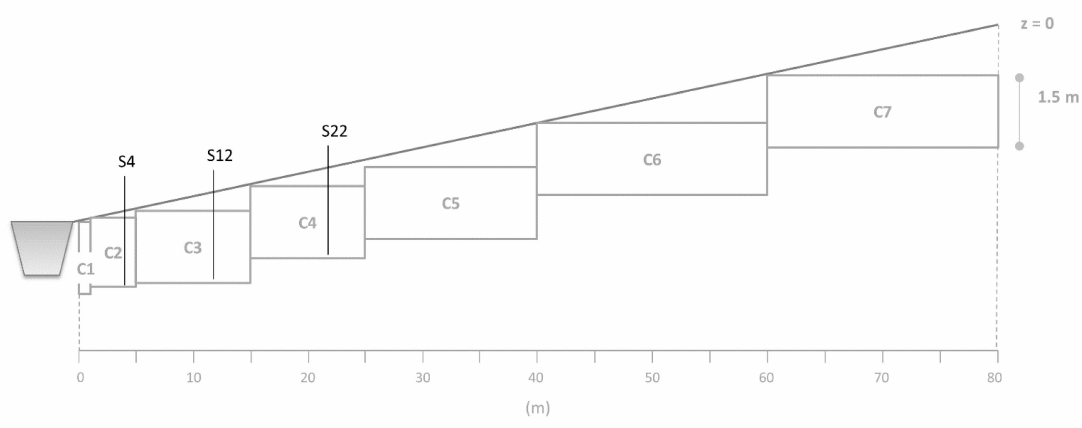
Figure 4. Representation of the S-transect in the hydrology model when the water divide is assumed at 80 m from the stream. C: modelled soil column. S: point of measurement. The number of the sampling points represents the distance from the stream (4, 12 and 22